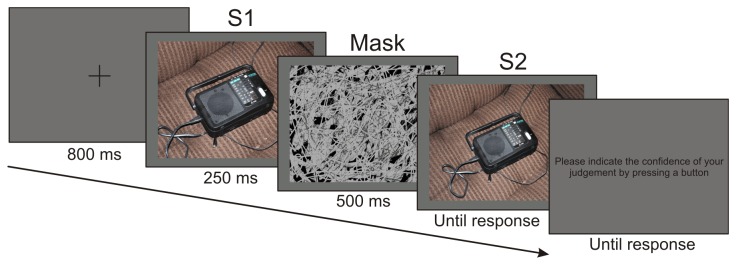
Schematic illustration of an experimental trial showing an example of a close-wide (CW) pair.Event durations are indicated under each screen.